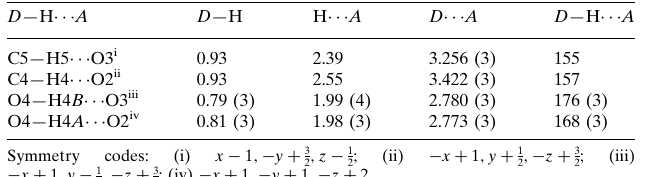
Hydrogen-bond geometry (A˚ , (cid:1)